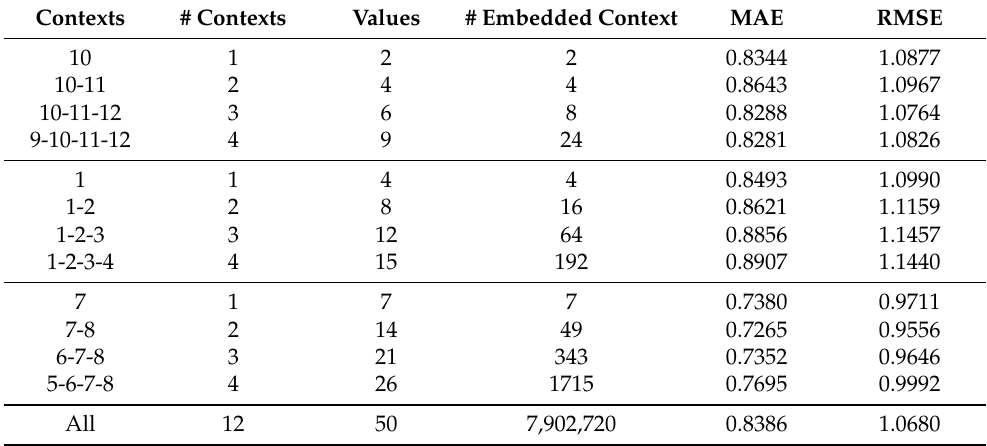
Table 6. Numerical results of the experiments tested on the LDOS-CoMoDa dataset based on the division into groups of contextual